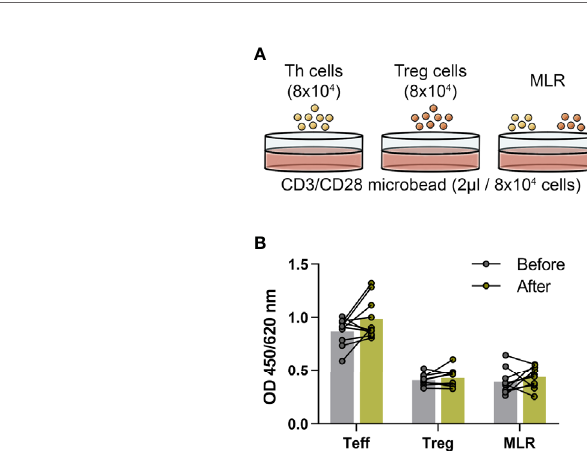
FIGURE 6 | Suppressor activity of regulatory T cells in elderly women before and after the functional exercise program. (A) The schematic representation of the culture settings of the proliferations of CD4 + CD25 - effector Th and CD4 + CD127 lo/- CD25 + Treg cells and mixed lymphocyte reaction (MLR) of Th and Treg cells in the presence of human T cell activator CD3/CD28 microbead for 72 hours. (B) The bar chart indicates the proliferations of Th, Treg cells and MLR. In the case of MLR, the Treg corrected optical density (OD) is displayed. (C) Suppressor activity index of Treg cells. Paired T test was used. Each data point represents an individual subject, while bars show the mean